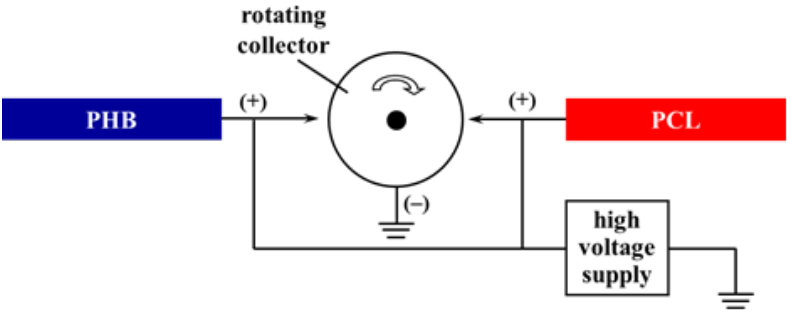
Figure 1. Scheme of the experimental dual-jet electrospinning set-up.